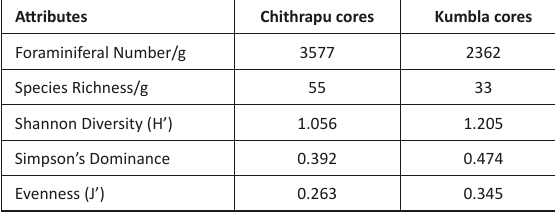
Table 2. Diversity attributes of Foraminifera in sediment cores